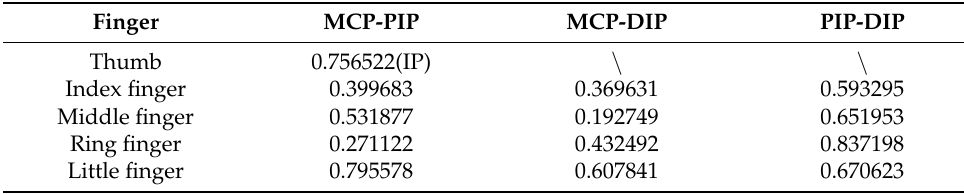
Table 3. Pressure correlation coefficient of the three-finger